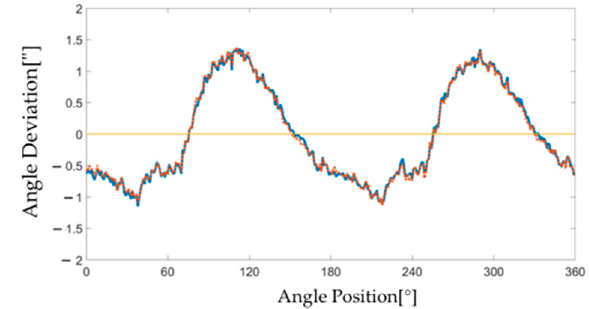
Figure 11. Calibration results for the rotary encoder obtained using self-calibration and shift-angle method. Self-calibration, red dash line; and shift-angle method, blue solid line.